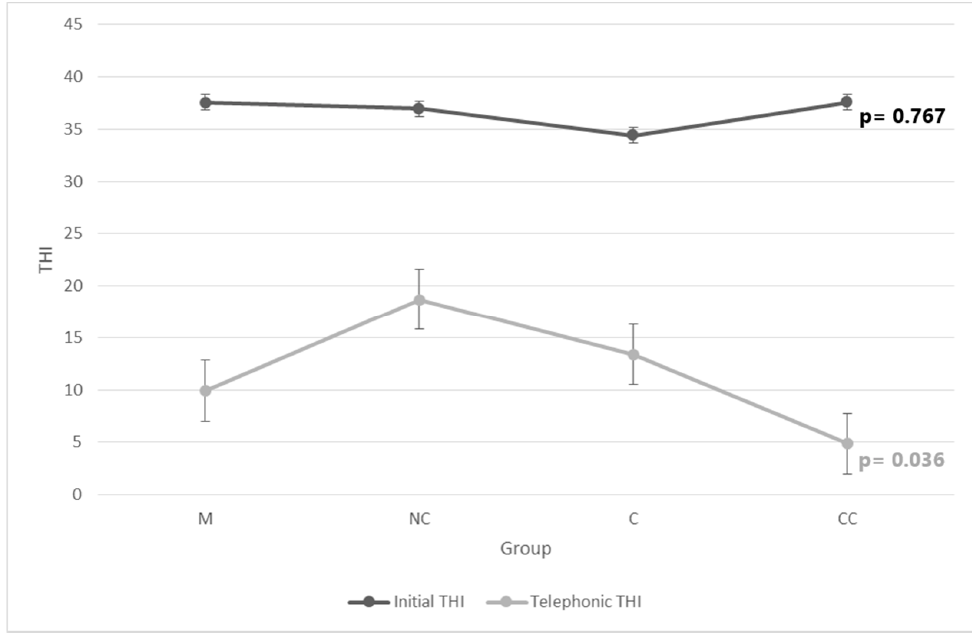
Figure 1. Initial and telephonic THI values in each study group with their relative error bars and significance.